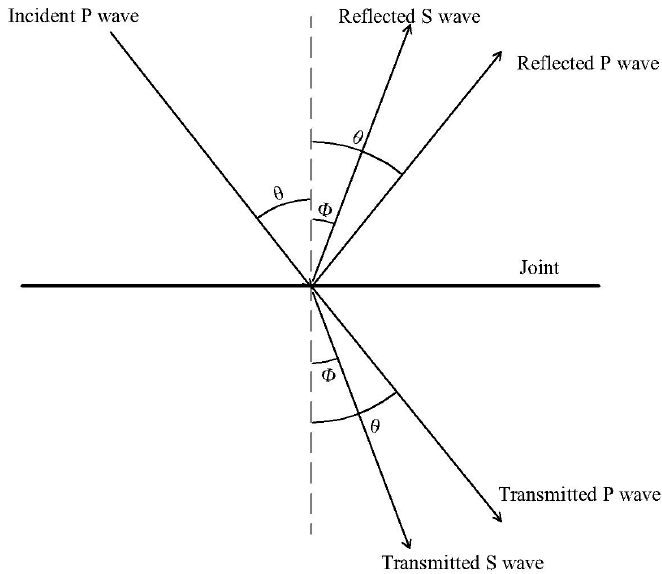
Figure 5. Obliquely incident wave transmission, reflection, and transmission on a joint.